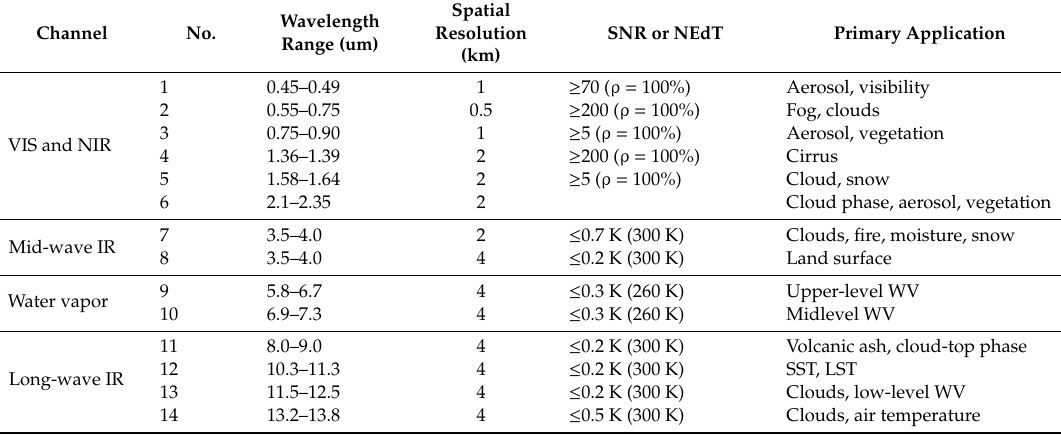
Table 1. Advanced Geostationary Radiation Imager (AGRI) channel characteristics of wavelength range, spatial resolution, SNR at 100% albedo for VIS and NIR channels, and noise-equivalent di ff erential temperature (NEdT) for IR